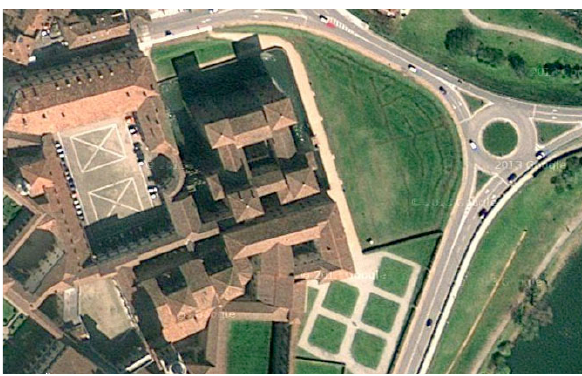
Figure 1. The Palazzo Ducale and the Castello di San